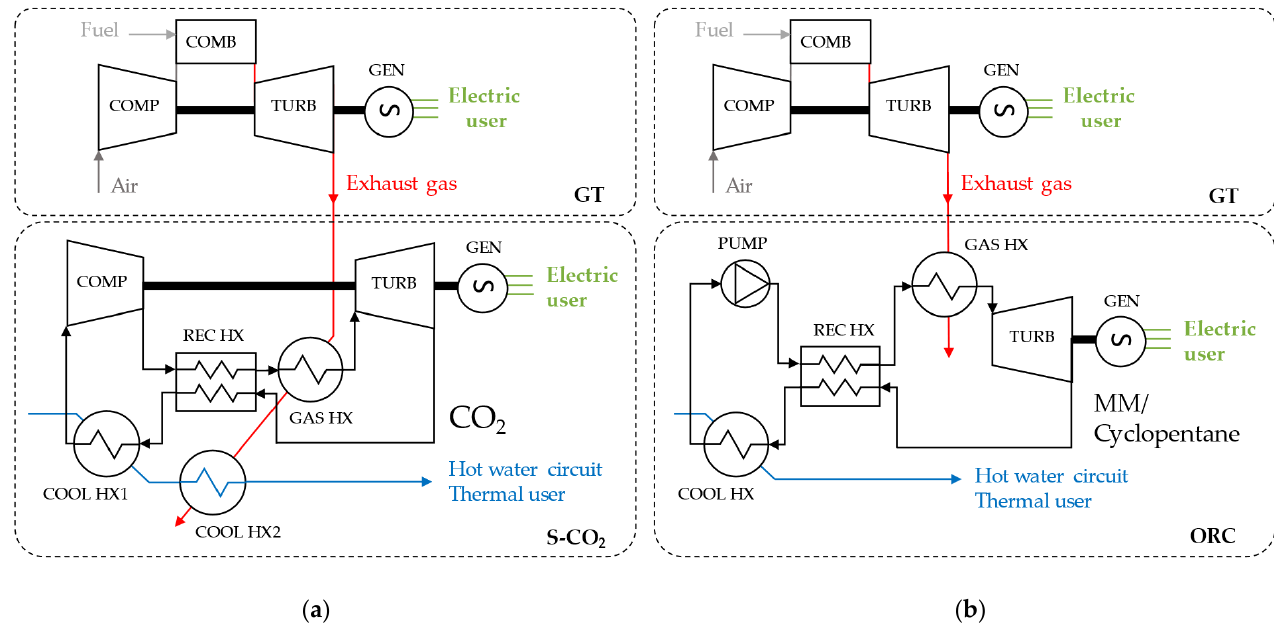
Figure 3. Heat recovery configurations layout: ( a ) s-CO 2 ; ( b ) ORC.